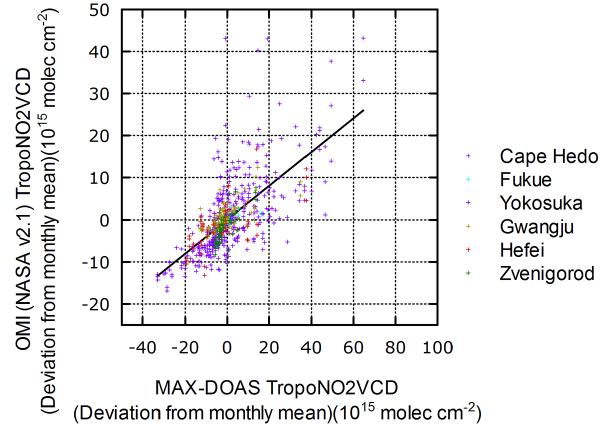
Figure 12. Same as Fig. 9b but deviations from monthly mean val- ues are plotted.